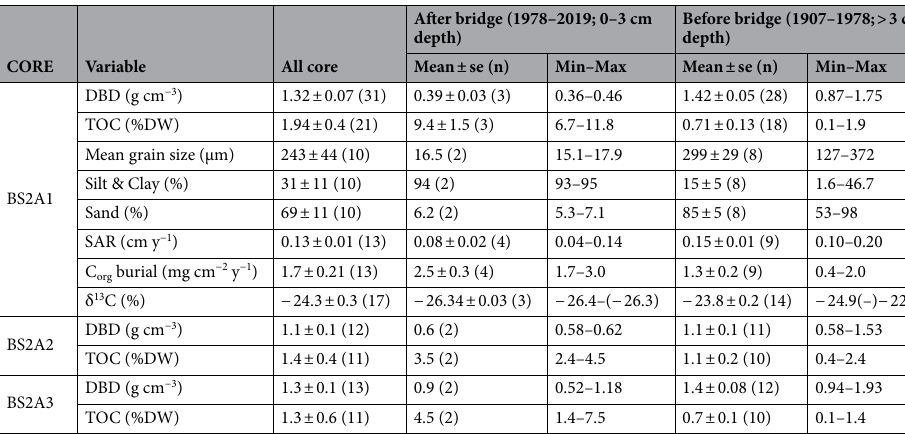
Table 1. Biogeochemical properties examined along the sediment depth and across accumulation periods in the three saltmarsh sediment cores analyzed (BS2A1, BSA2 and BSA3).